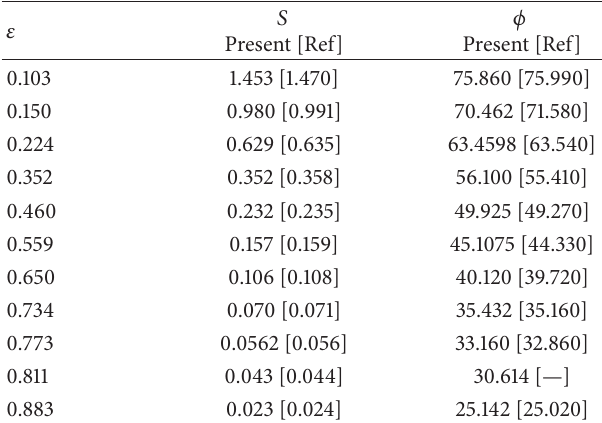
Table 9: Comparison of present results with [2] for 𝐿/𝐷 = 1 and 20 ∘ axial groove for groove in the horizontal